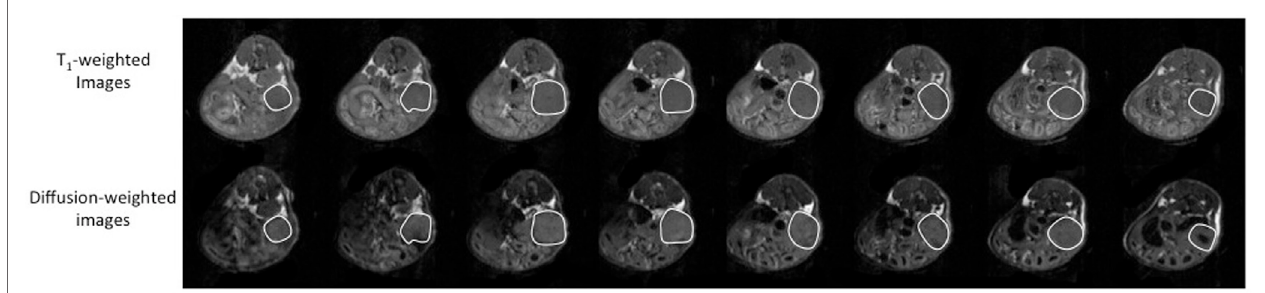
FigUre 1 | representative adjacent T 1 -weighted images (top row) and diffusion-weighted images (bottom row) of an orthotopically implanted OVcar3 tumor-bearing mouse . The tumor is highlighted by a white line. The tumor volume was measured by determining the tumor area on each 1-mm thick slice and by adding the areas to calculate the total tumor